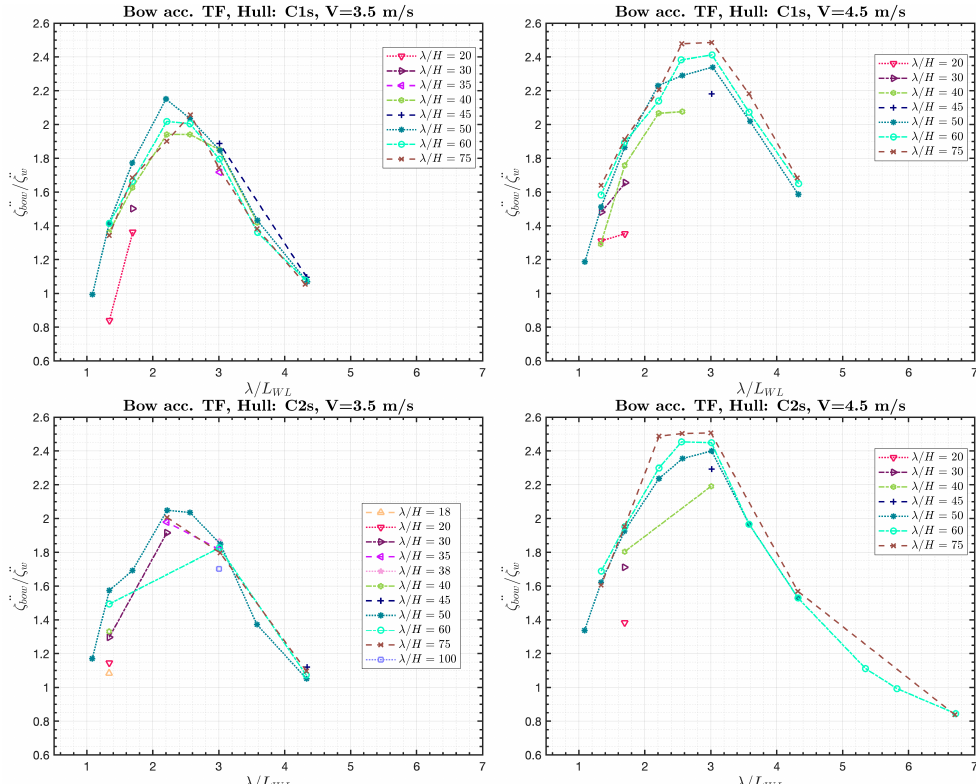
Figure 6. Vertical bow acceleration transfer functions vs. λ / L WL .